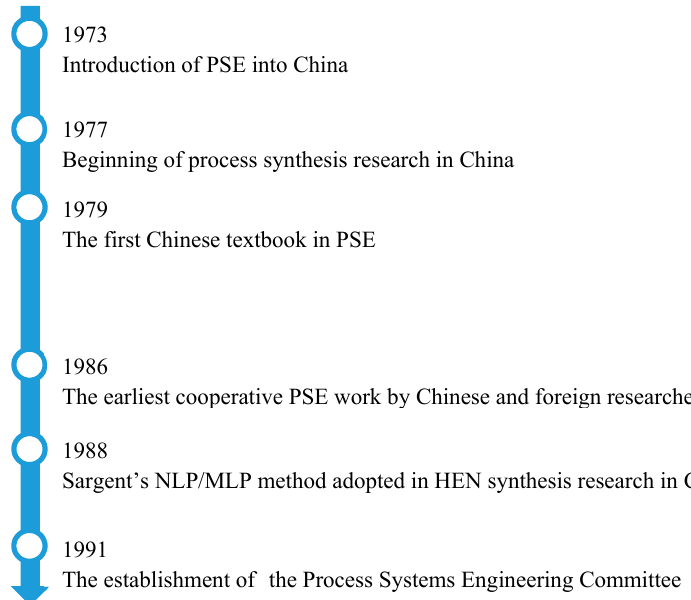
Figure 2. Important event in the development of process systems engineering (PSE) in China.